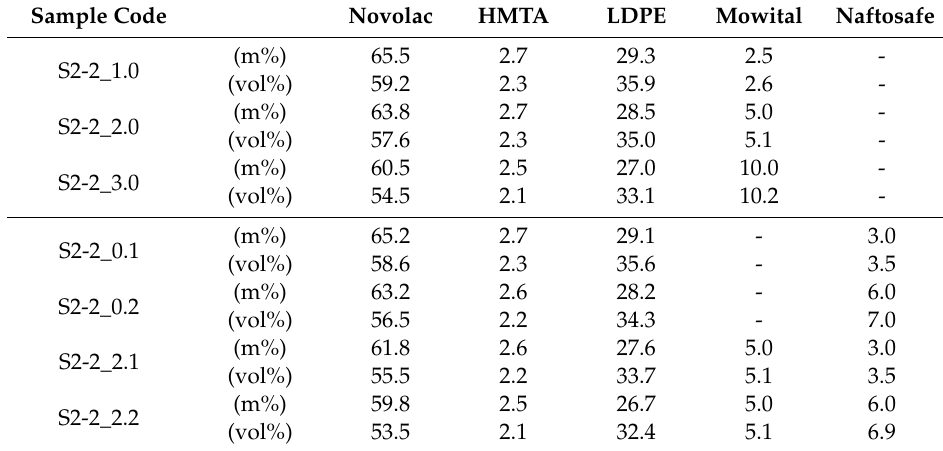
Table 3. List of the formulations prepared for Series 2. Explanation of the nomenclature S2-2_M.N : S2-2 → Series 2, and (novolac + HMTA)–LDPE mass ratio = 70:30 as defined in Series 1; M.N → presence of Mowital (M) and Naftosafe (N), with higher numbers representing larger amounts.